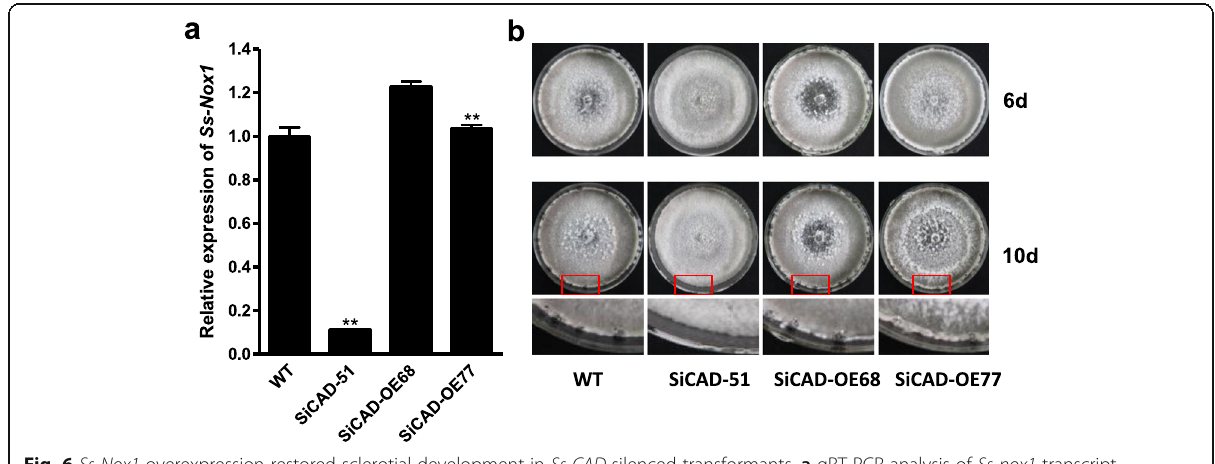
Fig. 6 Ss-Nox1 overexpression restored sclerotial development in Ss-CAD -silenced transformants. a qRT-PCR analysis of Ss-nox1 transcript accumulation. The cDNA abundance obtained from the wild-type strain was assigned a value of 1.0. Three independent replicates were performed. Values are means ± S.E. ** P < 0.01; one-way ANOVA. b Sclerotial development in the SiCAD-OE68 and SiCAD-OE77 Ss-Nox1 - overexpressing strains on PDA. Sclerotial development was defective in SiCAD-51 and was restored in Ss-Nox1 -overexpressing strains. Photographs were taken at 6 dpi and at 10